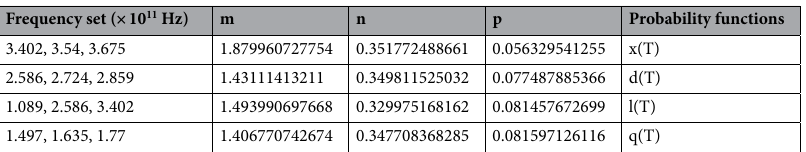
Frequency set (× 10 11 Hz) m n p